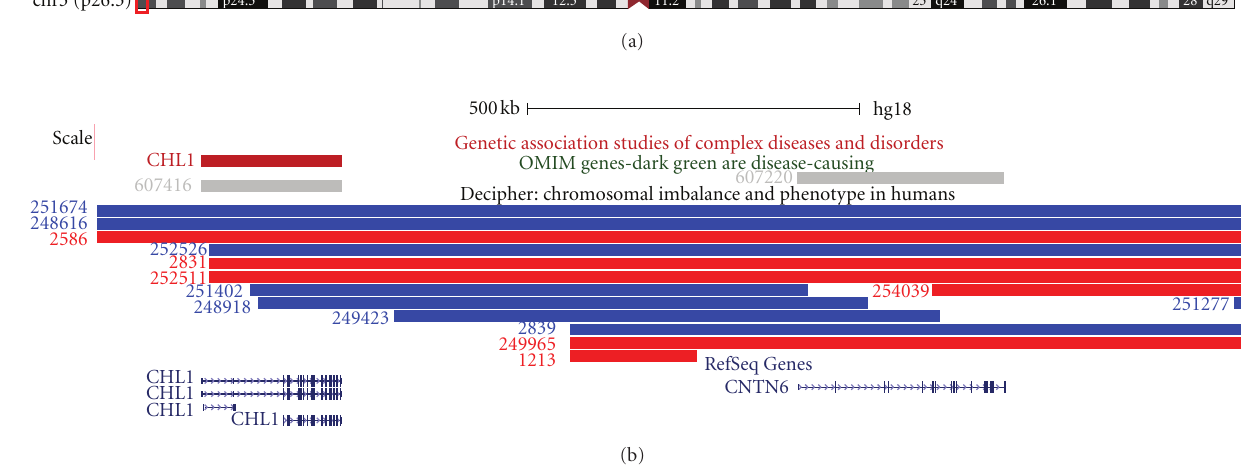
Figure 2: Schematic of the deleted chromosome 3 region in the proband. Panel A shows an ideogram of chromosome 3, together with the location of the deletion indicated in red. Panel B shows the genes that are localised within the deleted region, those reported in the OMIM database (http://www.ncbi.nlm.nih.gov/omim/) together with the location and extent of duplications (shown in blue) and deletions (shown in red) in patients reported in the DECIPHER database (http://decipher.sanger.ac.uk/). The images presented here are taken from the UCSC genome browser (http://genome.ucsc.edu/).